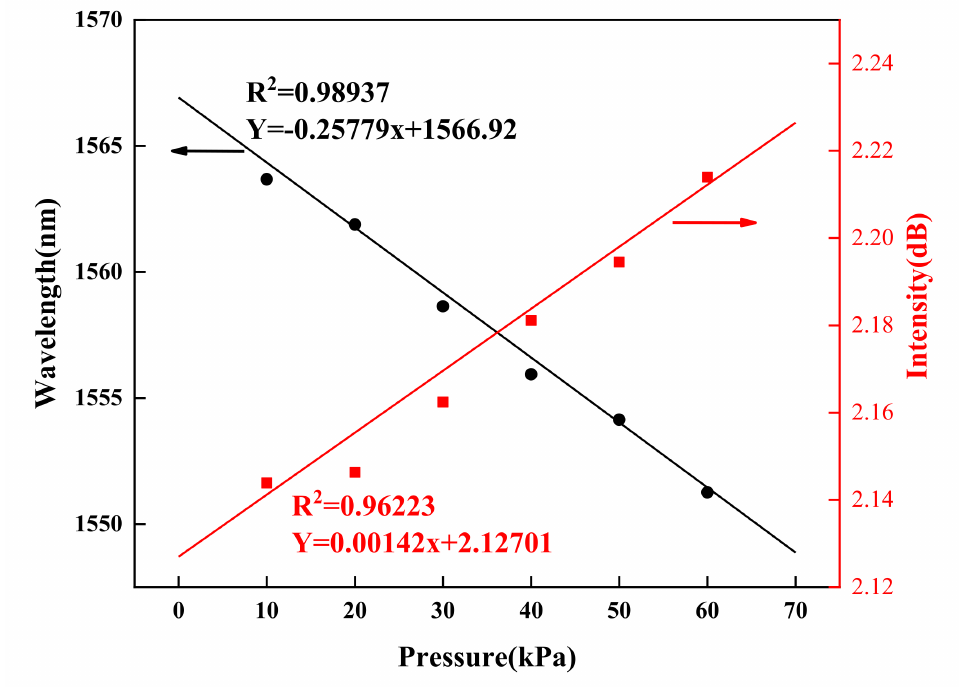
Figure 10. Wavelength and intensity shift with gas